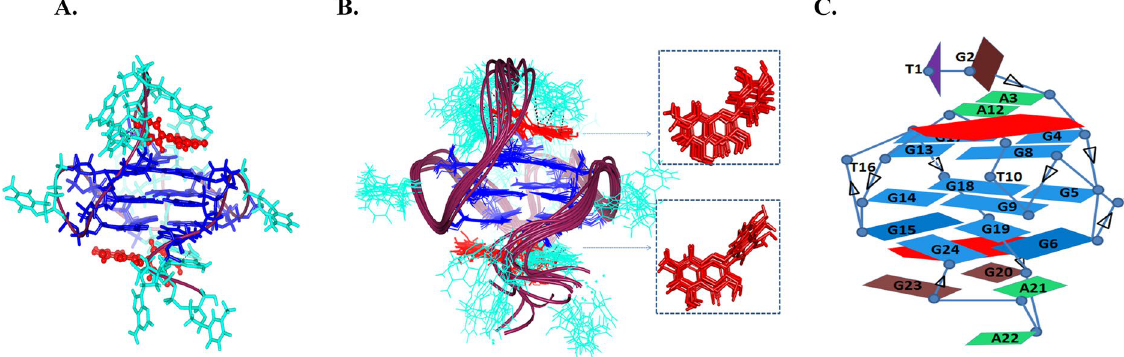
Figure 9. Quercetin and Pu24T complex at D/N = 2.0. ( A ) Lowest potential energy model of the complex after rMD simulation. Black dashes showing hydrogen bond formed between Quercetin (red) and Pu24T DNA. All the three G-tetrads are shown in blue and rest nucleotides are shown in cyan color, DNA backbone is shown in worm-representation. ( B ) Ensemble of ten lowest energy structures after restrained molecular dynamics simulation. (PDB Code: 2N6C) ( C ) Schematic representation showing Quercetin (red) stacking at 5 ′ G-tetrad and 3 ′ G-tetrad of Pu24T G-quadruplex